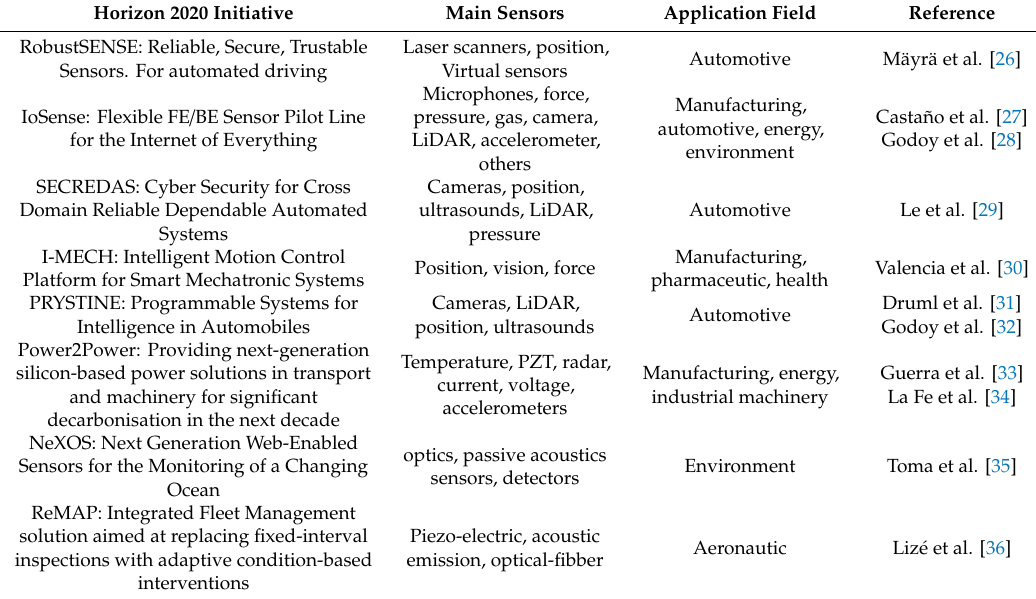
Table 1. Research and innovation actions in sensor reliability supported by H2020 Programme in the last five years. Horizon 2020